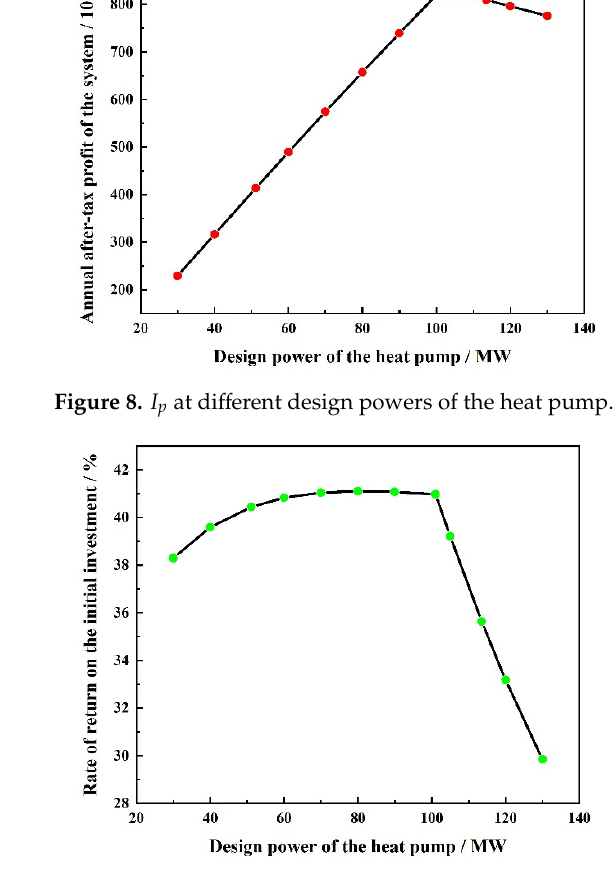
Figure 9. ROI at different design powers of the heat pump.